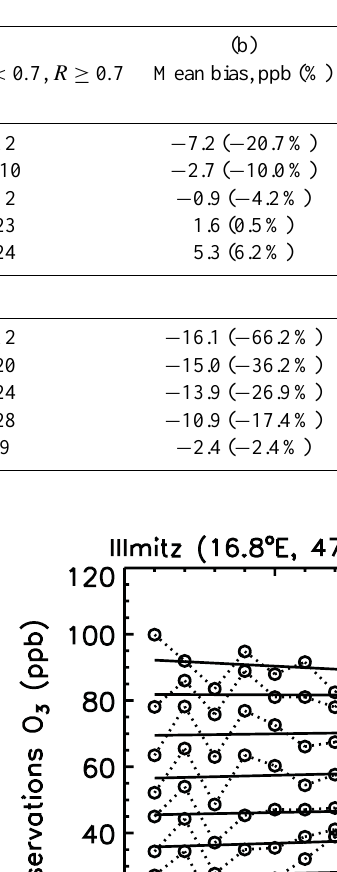
Table 2. Model performance metrics for the daily maximum 8-h average summer O 3 concentration at all available sites for 1991–2005 for 5 percentiles. Column a: the three numbers correspond to the number of sites with correlation coefficient lower or equal to 0.3, between 0.3 and 0.7, and greater than or equal to 0.7, respectively. Column b: The mean bias is calculated for each site and then averaged to display in this table. Results are shown separately for sites in Europe and US.